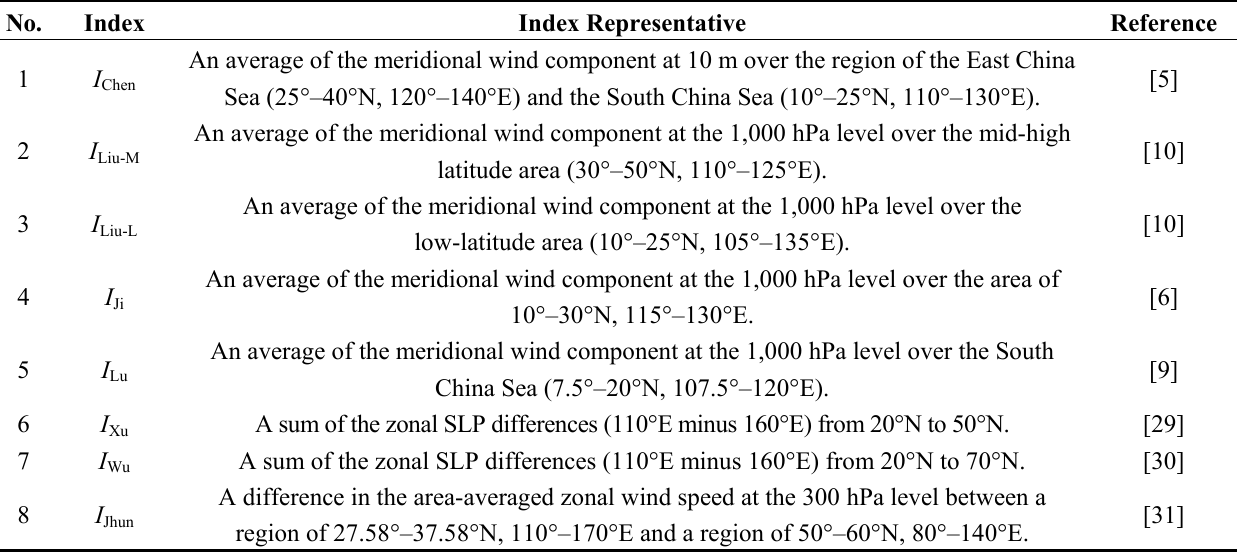
Table 1. The selected East Asia winter monsoon (EAWM) indices for the correlation analysis. SLP, sea level